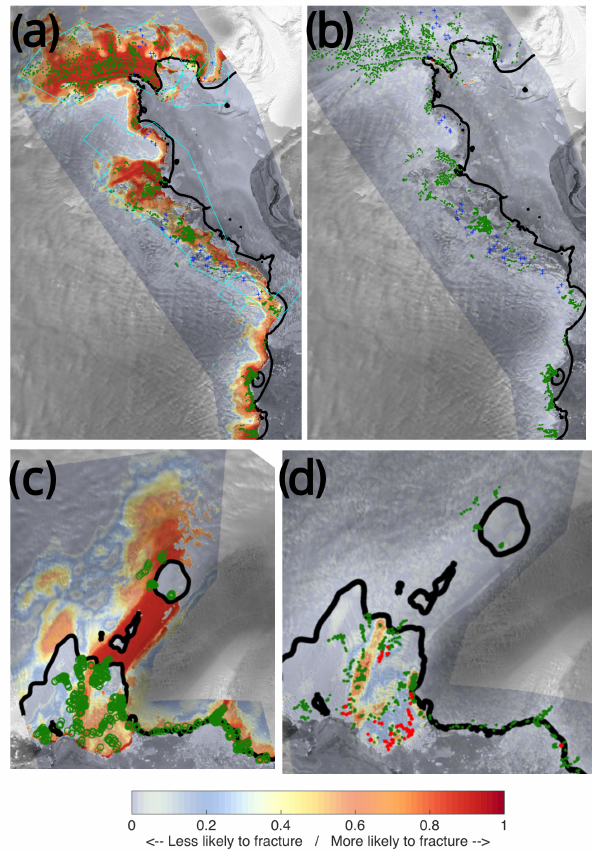
Figure 12. Modelled probability of a fracture vs. modelled damage for Shirase IS (group 2) (a, b) and Totten IS (group 3) (c, d) . Labels are the same as in Figs. 5 and